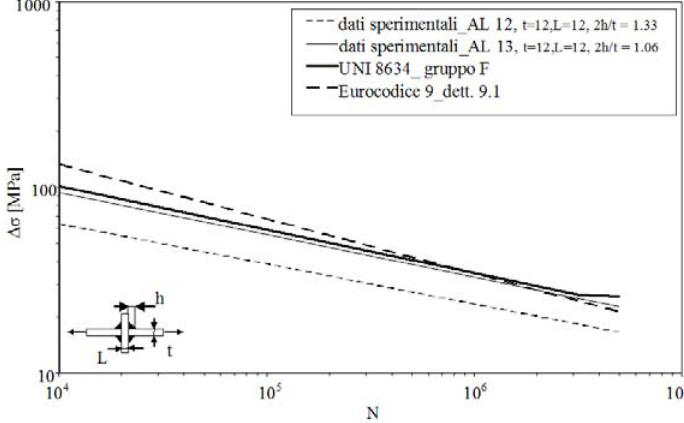
Figura 13: Confronto tra curva di resistenza a fatica per giunti a croce, cordone portante.